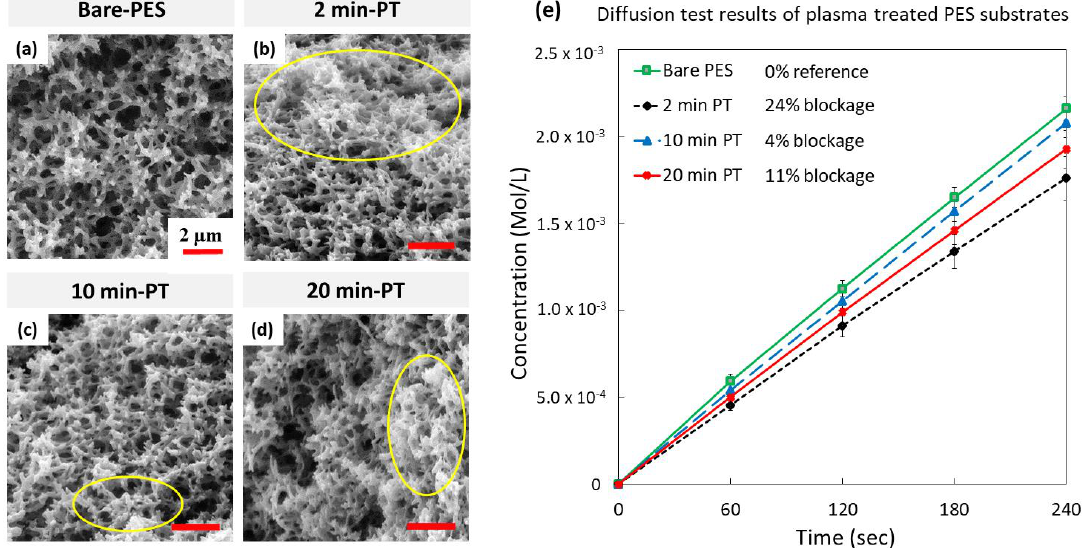
Figure 3. SEM micrographs of the PES membrane surface morphology as a function of the PT exposure time: ( a ) bare-PES, ( b ) 2 min PT, ( c ) 10 min PT, and ( d ) 20 min PT. Yellow ellipses indicate